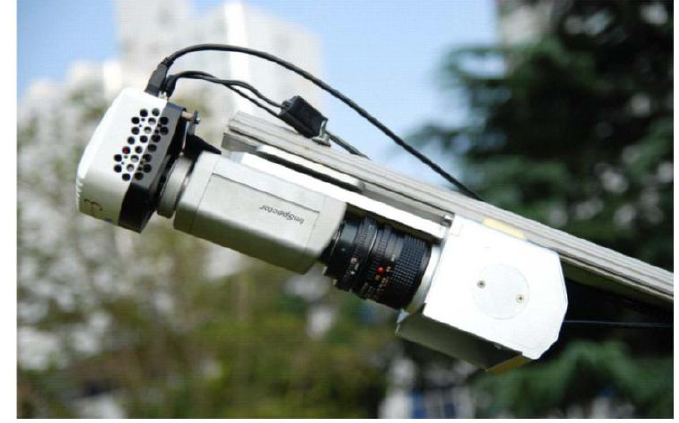
Figure 3. Photograph of the FISS optomechanical subsystem: from upper left to lower right of the enclosed optomechanical subsystem are the CCD camera, which is built with area array detectors and a cooling device, the dispersing unit with a “prism-grating-prism” (PGP) element, the objective lens, and the scan mirror. The latter is attached to a stepper